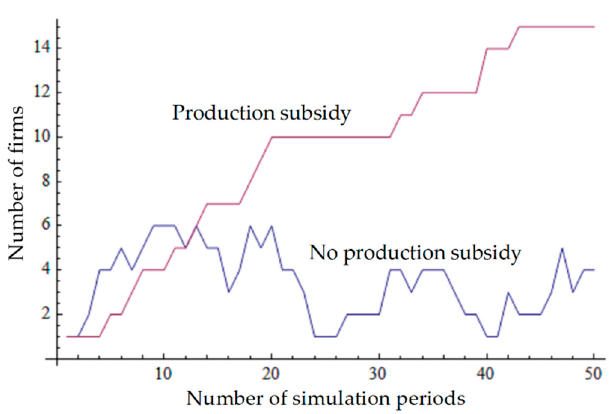
Figure 11. Impact of the production subsidy on the number of firms in the industry.